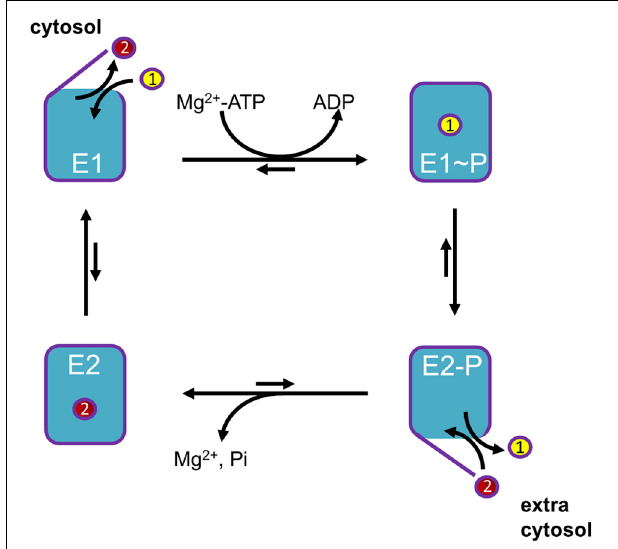
FIGURE 2 | General Post-Albers reaction scheme for P-type ATPases. A cytosolic ligand (yellow, transported ligand 1) is transported to the extracytosolic space, whereas an extracytosolic ligand (red, counter-transported ligand 2) is imported into the cytosol. Note that the number of ligands in each direction may vary between different P-type ATPase isoforms. In short, P-type ATPases switch between two major conformations E1, with ligand binding sites facing the cytosol, and E2, with ligand binding sites facing the extracytosolic side of the membrane. The induced fit of ligand 1 binding in E1 promotes phosphorylation by Mg + -ATP. In this E1 ∼ P state the ligand 1 becomes occluded. The rate-limiting E1 ∼ P to E2-P transition is accompanied by major conformational changes, reorienting the ligand-binding sites toward the extracytosolic space. This decreases the affinity of the binding site for ligand 1, whereas the affinity for ligand 2 is increased. As a result, ligand 1 is released into the extracytosolic space via an open exit pathway for ligand 1 and the counter-transported ligand 2 can enter the binding cavity. The resulting conformational changes lead to dephosphorylation of E2P and the released inorganic phosphate is expelled. The ligand 2 becomes occluded, whereupon the pump is reset to the E1 state, reducing the affinity for ligand 2. The pump can now start a new